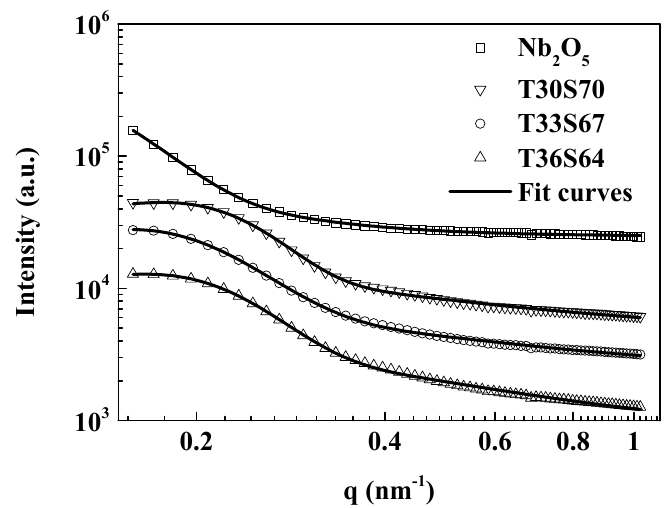
Figure 3. Experimental small-angle X-ray scattering (SAXS) profiles I ( q ) of the Nb 2 O 5 and TiO 2 –SiO 2 sols. The profiles are shifted vertically for clarity. The fit curves were obtained using the Beaucage model. Table 1. Structural parameters of the precursor solutions and optical properties of the corresponding films. Radii of gyration, R g i and Porod’s exponents, P i (for i = 1, 2), as obtained from the Beaucage model [44]. f denotes the objective function of the optimization process by selecting different TiO 2 – SiO 2 hybrid films for the triple-layer AR coating.